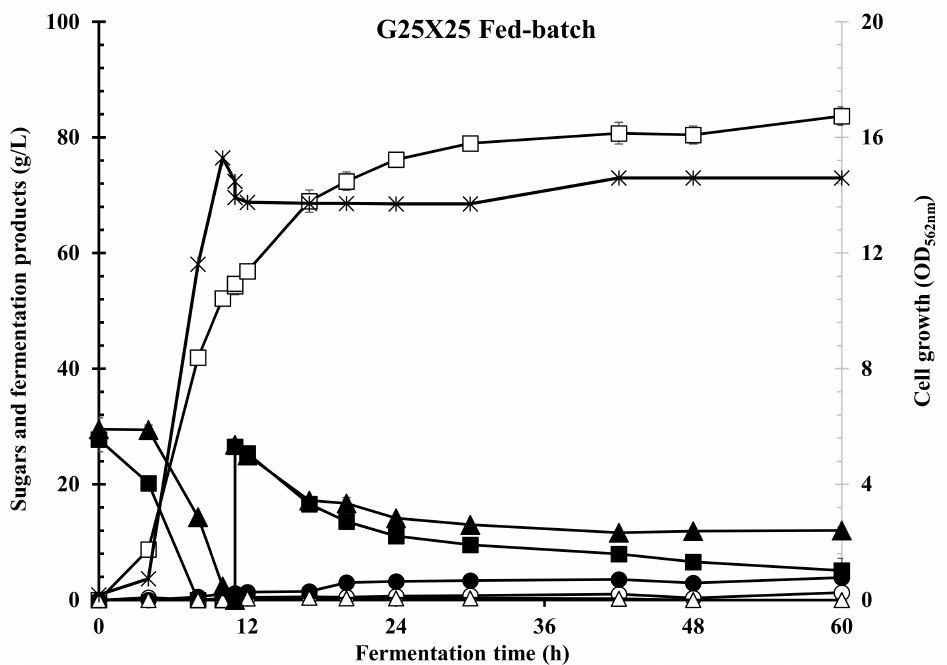
Figure 5. Fed-batch fermentation of glucose/xylose mixture for lactic acid production by B. coagulans Azu-10. Initial sugars were 25 g/L glucose and 25 g/L xylose [G25X25] and fed with same sugar concentrations after 12 h of fermentation. Symbols: (cid:4) , glucose (g/L); (cid:78) , xylose (g/L); (cid:3) , lactic acid